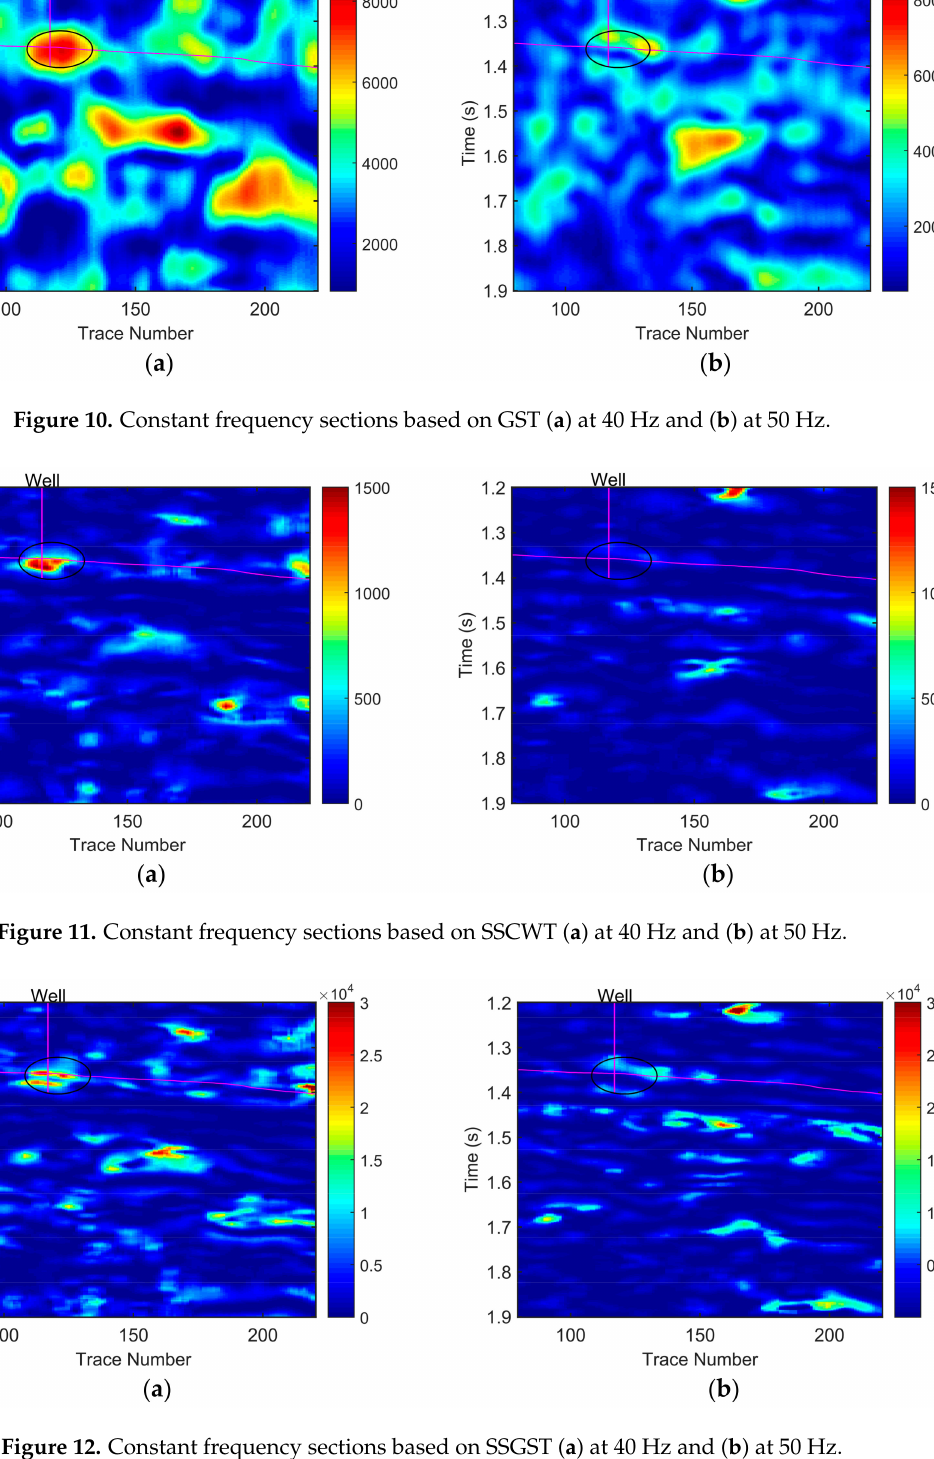
Figure 12. Constant frequency sections based on SSGST ( a ) at 40 Hz and ( b ) at 50